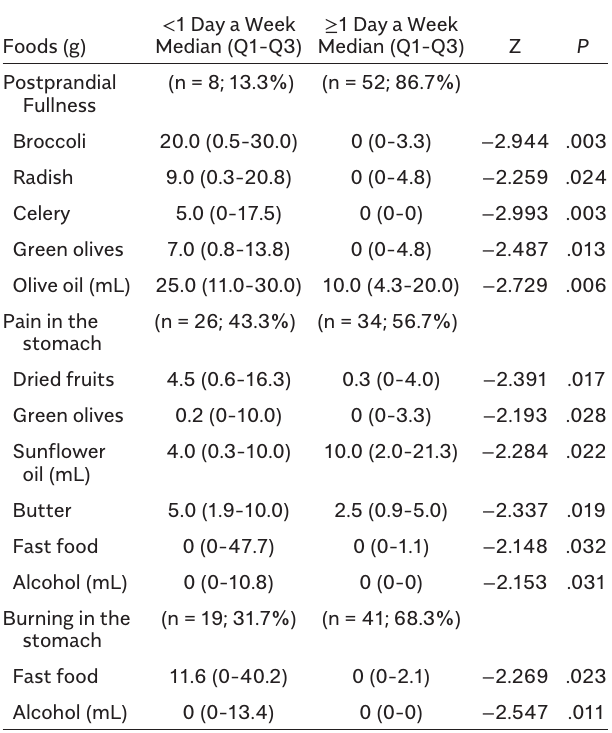
Table 5. Comparison of Daily Food Consumption According to FD Symptoms